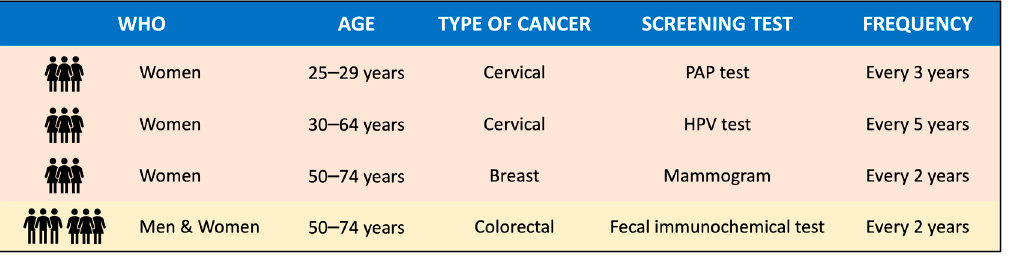
Figure 1. Cancer screening strategies are offered free of charge to all residents of Local Health Authority Rome 1 (Lazio Region, Italy). PAP: Papanicolaou. HPV: Human Papilloma Virus.